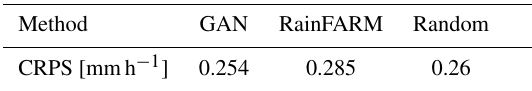
Table 1. CRPS scores of GAN and baseline methods for 10000 test